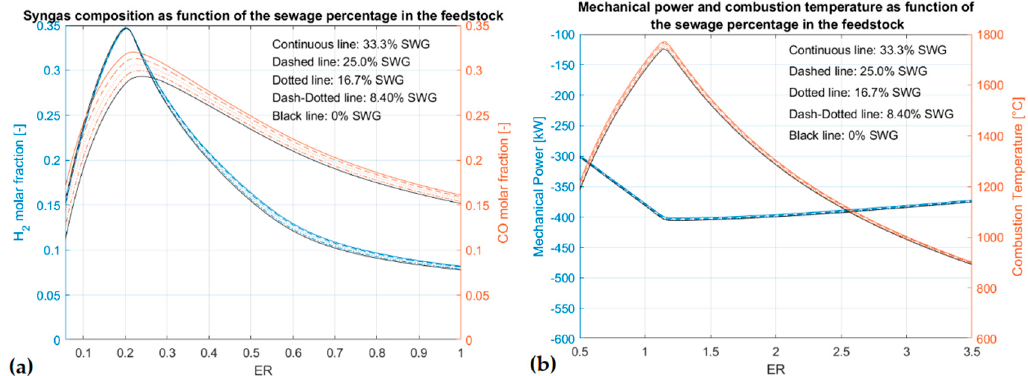
Figure 9. ( a ) H 2 and CO molar fractions as a function of sewage fraction and gasification ER; ( b ) Mechanical power and combustion temperature as a function of the sewage fraction and combustion ER.